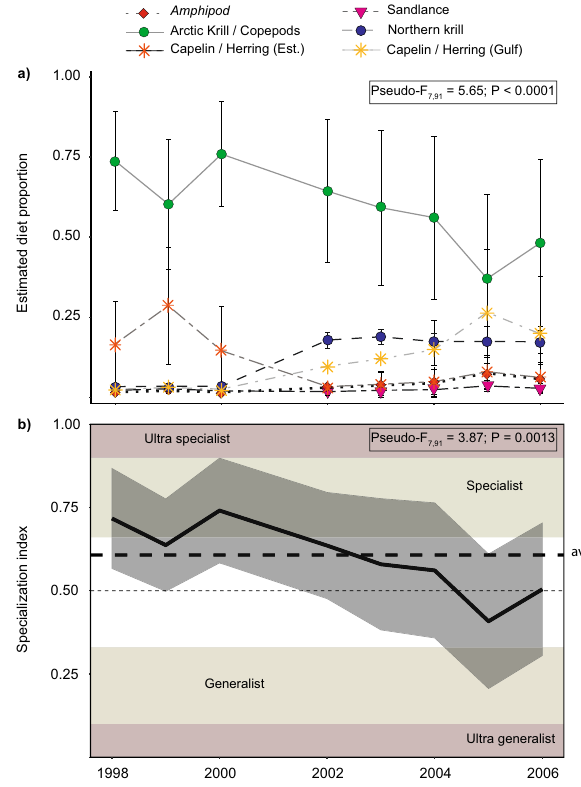
Figure 4. Inter-annual variation of (a) the estimated proportional contributions of each potential prey to fin whale diet from isotopic mixing models, with (b) the corresponding specialization index Ɛ over the study period (1998–2006). Avg. population